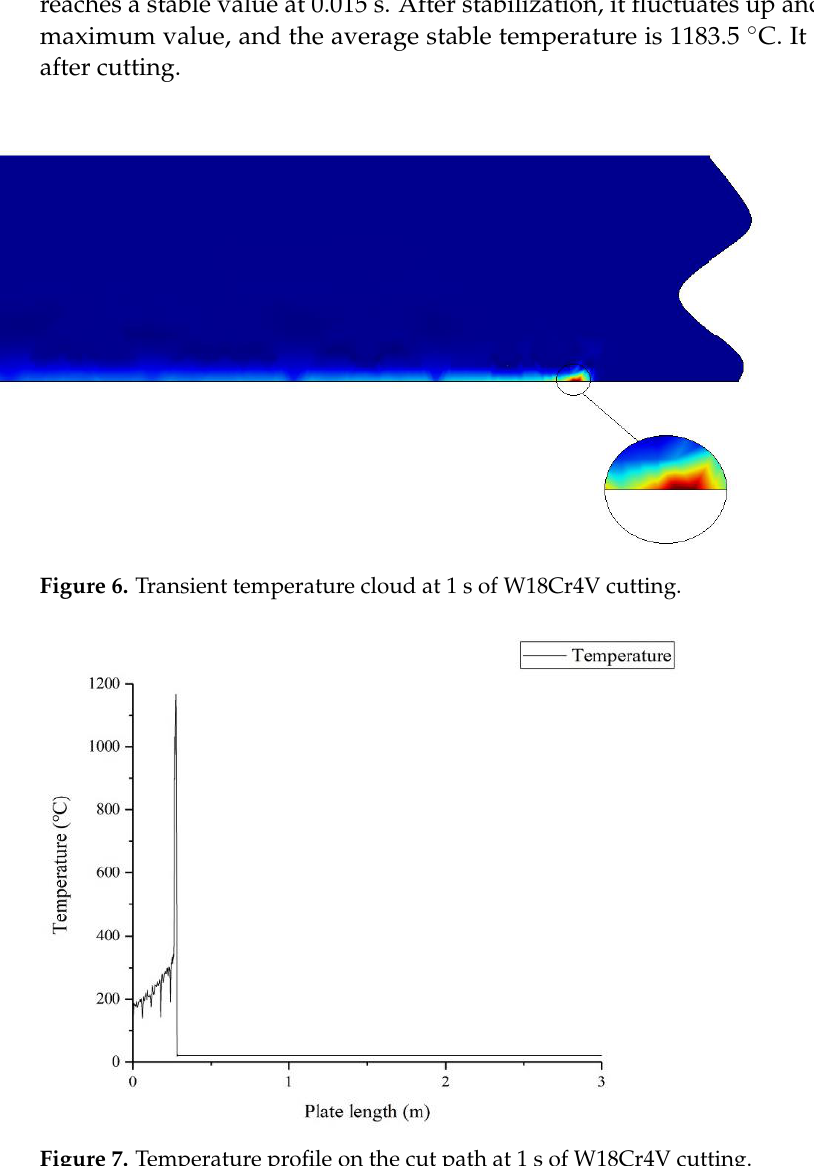
Figure 8. The curve of the maximum temperature at the W18Cr4V slit with time. Using the data obtained above, the mean value of the extreme heating time and the stable temperature was calculated via logistic regression and statistical analysis based on the Levenberg Marquardt algorithm and the Gauss – Newton linear model (instead of a nonlinear function), as shown in Table 3. Working conditions 1 – 4 use the same material W18Cr4V, and the thickness gradually increases. The time for condition 1 to reach stability is slightly longer than condition 2, which is 0.032 s. Under conditions 2 – 4, the stabilization time gradually becomes longer. The lowest stable temperature of the four working conditions is 1161.87 °C, and the high- est is 1197.89 °C. The processed material is Q235 under working conditions 5 – 8. With the increase in the thickness, the time to reach the stable temperature increases, and the long- est time is 0.84 s. The average stable temperature is close, all falling within the range of 1473.03 °C~1486.95 °C. The processed material is 2A12 aluminum alloy under working conditions 9 – 12. With the increase in the thickness, the stable temperature increases from 0.02 to 1.6 s. The stable temperature of working condition 9 is close to that of working condition 12, which is 676.36 and 674.94 °C. The stable temperature of working conditions 10 and 11 is slightly higher, reaching 762.72 and 747.68 °C.